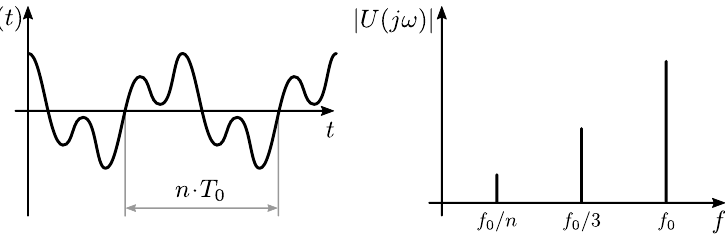
Figure 3. Ferroresonance characteristics for subharmonic oscillations.